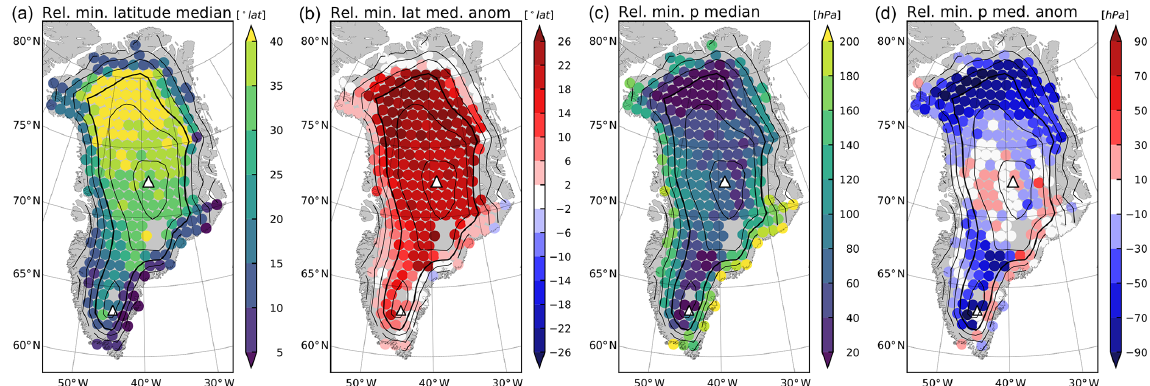
Figure 3. Lagrangian forward projection (LFP) of the median (a) relative minimum latitude, (c) relative minimum pressure (where positive values mean from (a) lower latitudes and (c) above), and (b, d) the respective anomaly fields of 8d melt trajectories of EV69 with respect to the climatological summertime air parcels. The contours indicate elevation in 500m intervals with the 2000m isoline in solid lines. Summit and South Dome are marked with triangles.